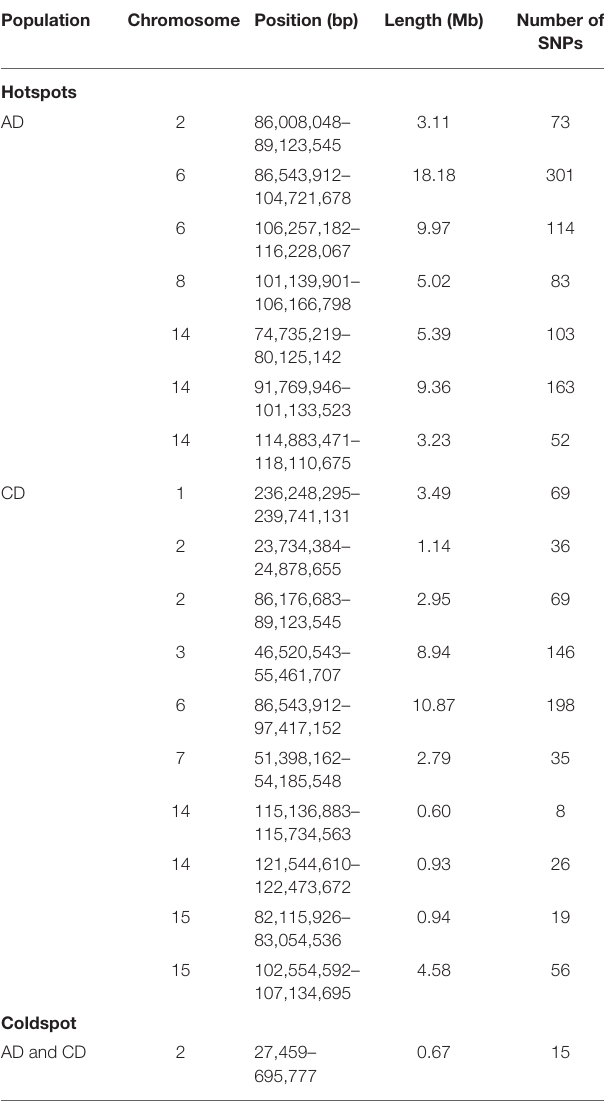
TABLE 2 | Distribution of ROH hotspots and coldspot in two Duroc lines. Population Chromosome Position (bp) Length (Mb) Number of